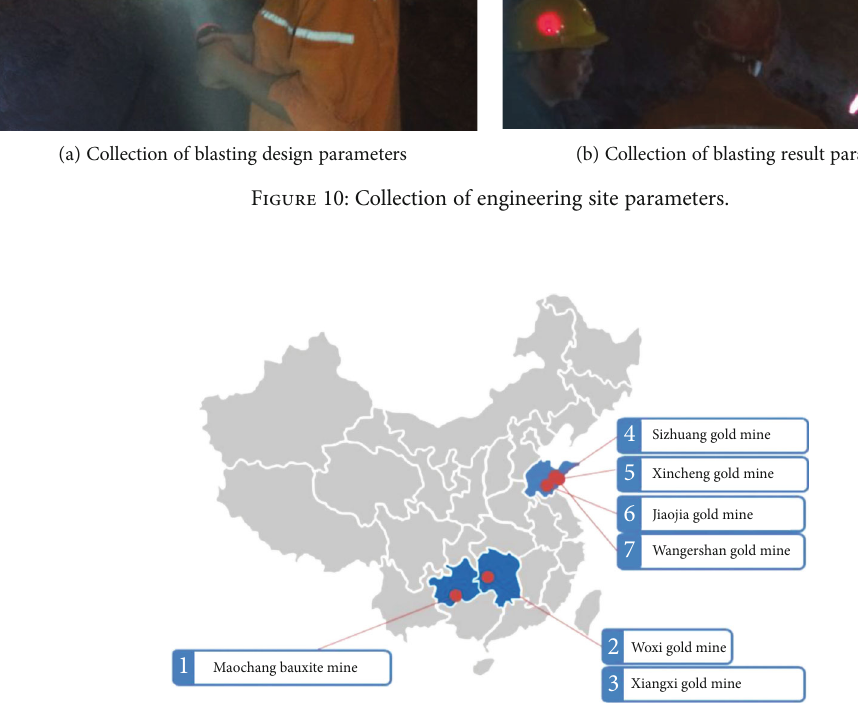
Figure 11: Data source and data distribution of tunnel blasting in the new